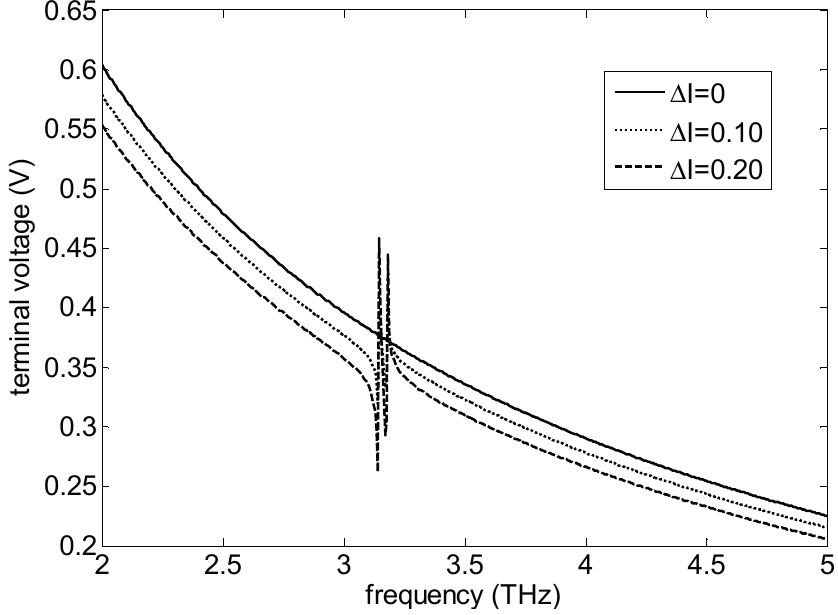
Figure 8. Resonance peaks for balanced and misbalanced